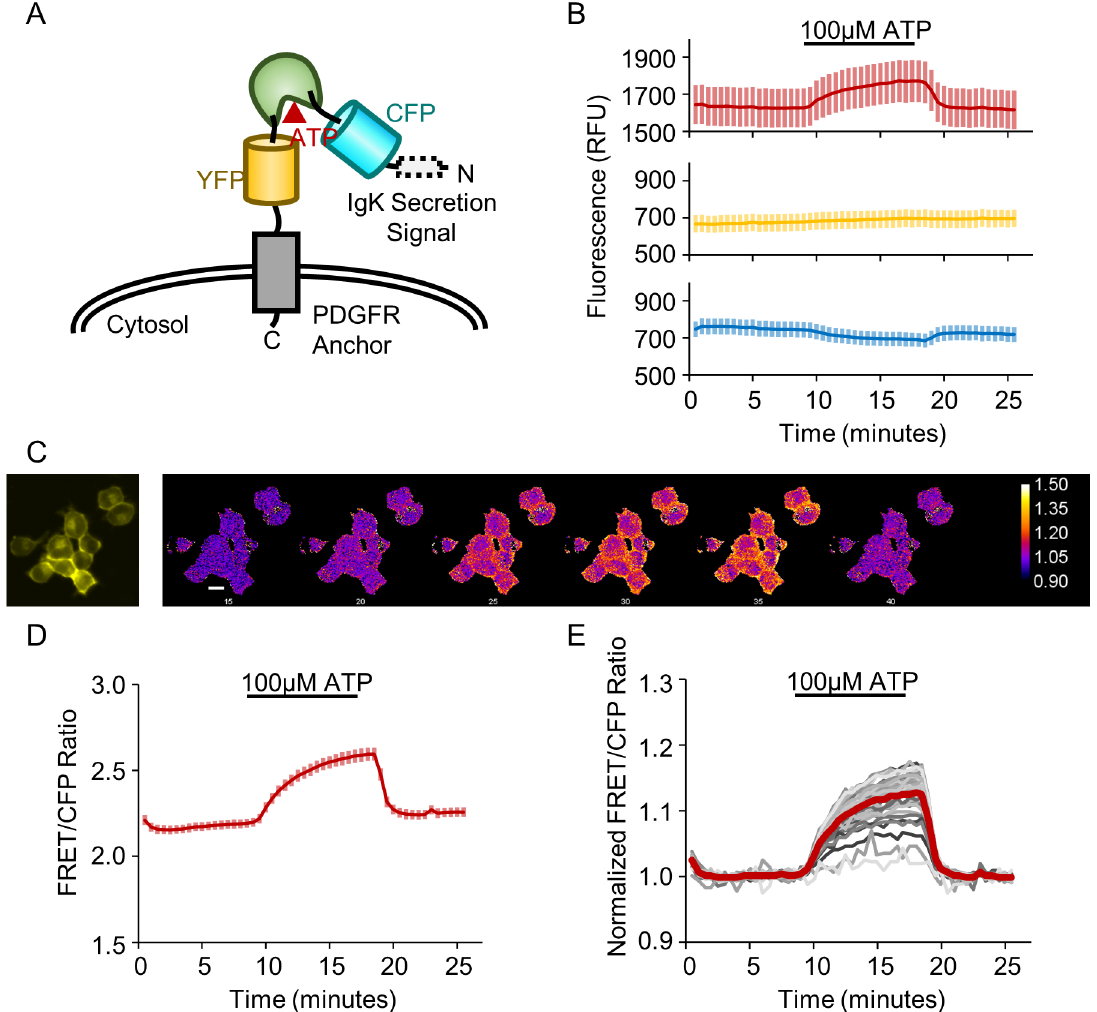
Fig 1. The ecATeam3.10 sensor detects extracellular ATP. (A) Schematic of ecAT3.10 design in which the ATeam3.10 FRET-based ATP sensor is displayedon the cell surface via a PDGFR transmembrane anchor. (B) Fluorescence intensity in the FRET channelincreasesupon wash-inof 100 μ M ATP whilethe CFP donor intensity decreases. As expected, the YFP direct acceptor channeldoes not show an ATP-dependent change.Cells were imagedunder continuous perfusion. (C) Representative widefieldfluorescence images for the cells analyzedin (D-E). The first panel in the YFP channelshows morphology, the subsequent panels are false colored to show the changein the normalized FRET/CFP pixel-by-pixelratio signal.Scale bar is 20 μ m.(D) The averageFRET/CFP emissionratio, which we refer to as the ratio signal,shows a robust increaseof 0.27 ± 0.01 (n = 41 cells). Valuesand solid line traces are cell means, and errors and error bars are standard errors of the means. (E) To account for drift, a linear baselinewas fitted, and the ratio signal was normalized on a cell-by-cell basis (individual cells, gray), showingan averagefold changeof 1.127 ± 0.005